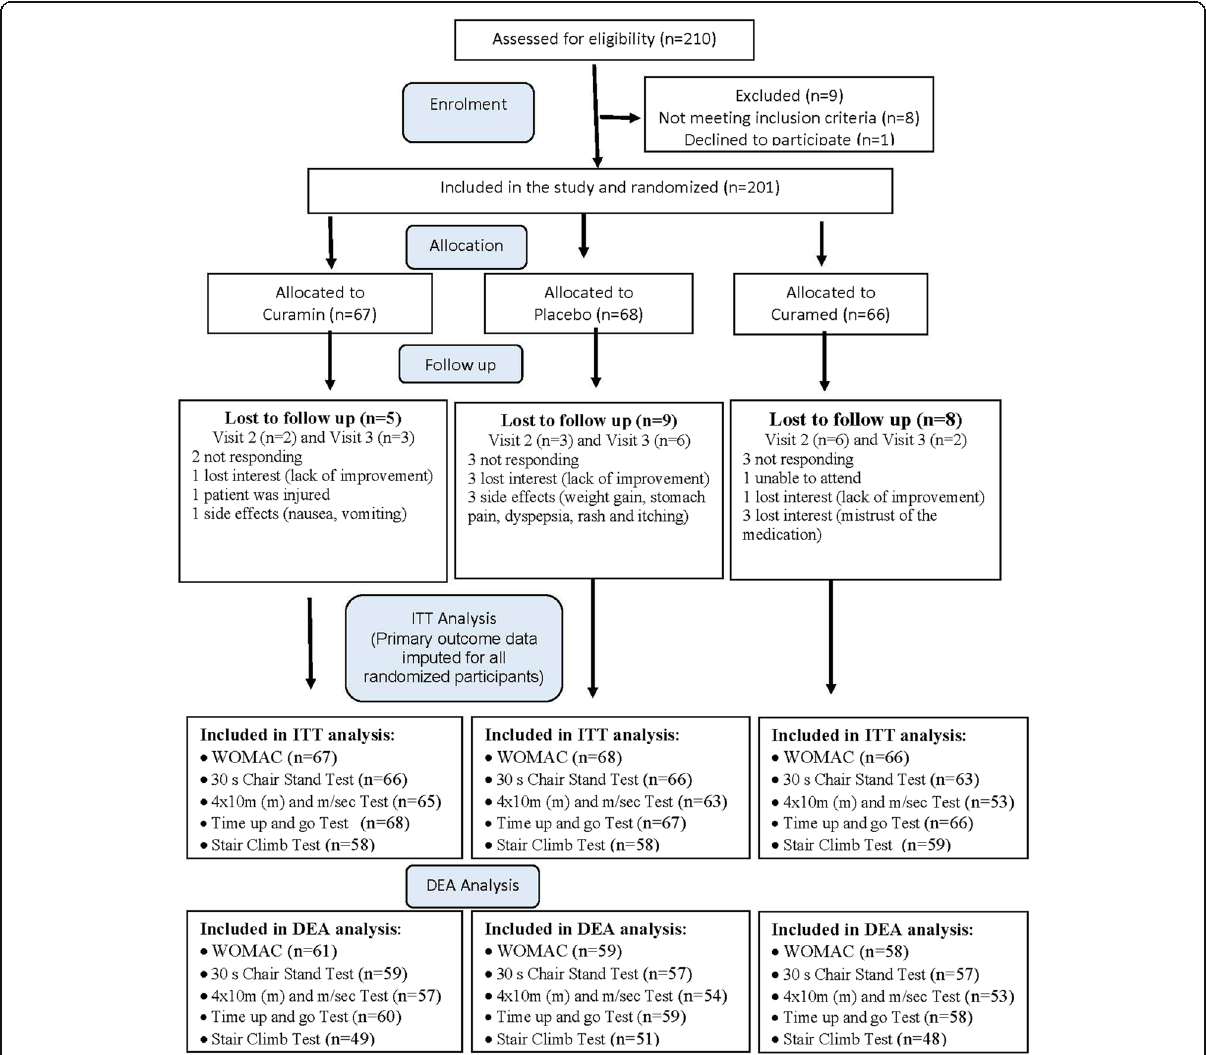
Fig. 1 CONSORT Diagram - participant flow chart. ITT – intention to treat analysis, which includes all patients who completed the tests. DEA – dropouts excluded analysis, which includes only patients who completed all tests during all 3